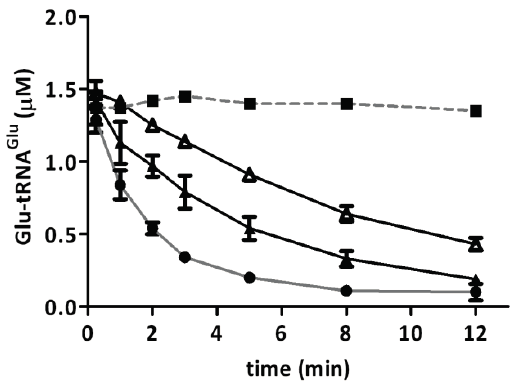
Table 1. Inactivation rates ( k obs ) of GluTR by H 2 O 2 . Numbers in parentheses